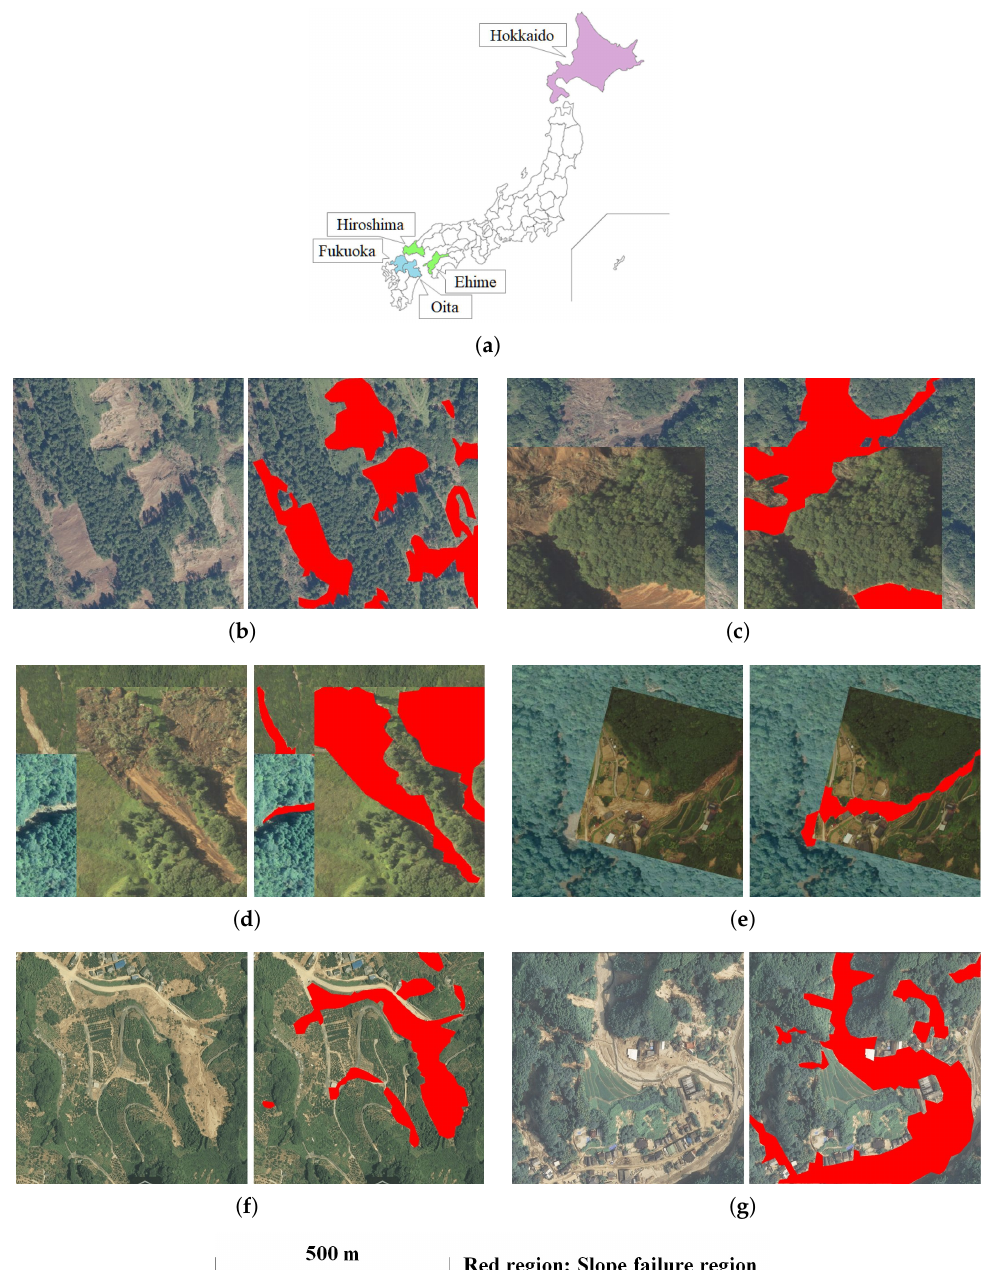
Figure 2. Images used in each case ( Left : Aerial photograph. Right : Ground truth.) ( a ) Aerial photograph acquisition areas (The blue areas are the areas affected by the July and September 2017 heavy rains; aerial photographs of these areas were used as test data. The green and purple areas are the areas affected by the July 2018 heavy rains and earthquake, respectively; aerial photographs of these areas were used as training and validation data.) ( b ) Original image used in Case 1. ( c ) Image with one time CutMix processing used in Case 2. ( d ) Image with two times CutMix processing used in Case 3. ( e ) Image with rotation and warping applied to the one time CutMix image used in Case 4. ( f ) Image for validation case. ( g ) Image for test